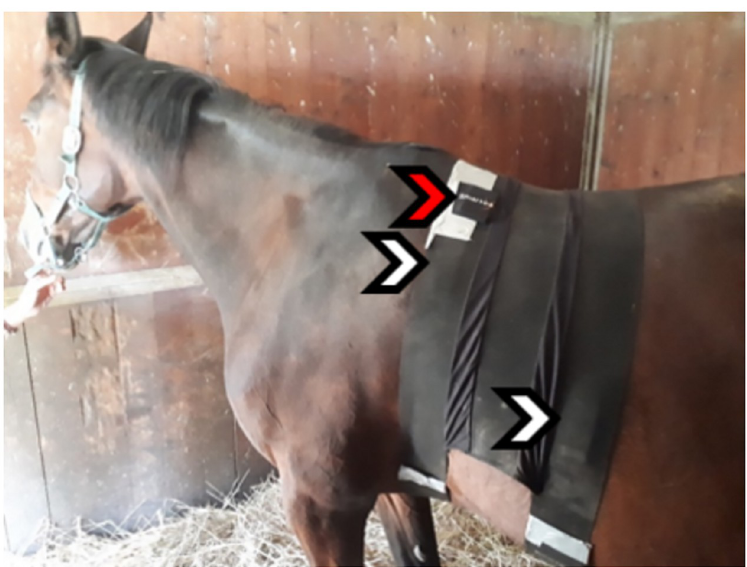
Fig 1. Position of the belt with integrated textile electrodes (Smartex SRL, Pisa, Italy). Red Arrow electronic system and White Arrow textile electrodes.